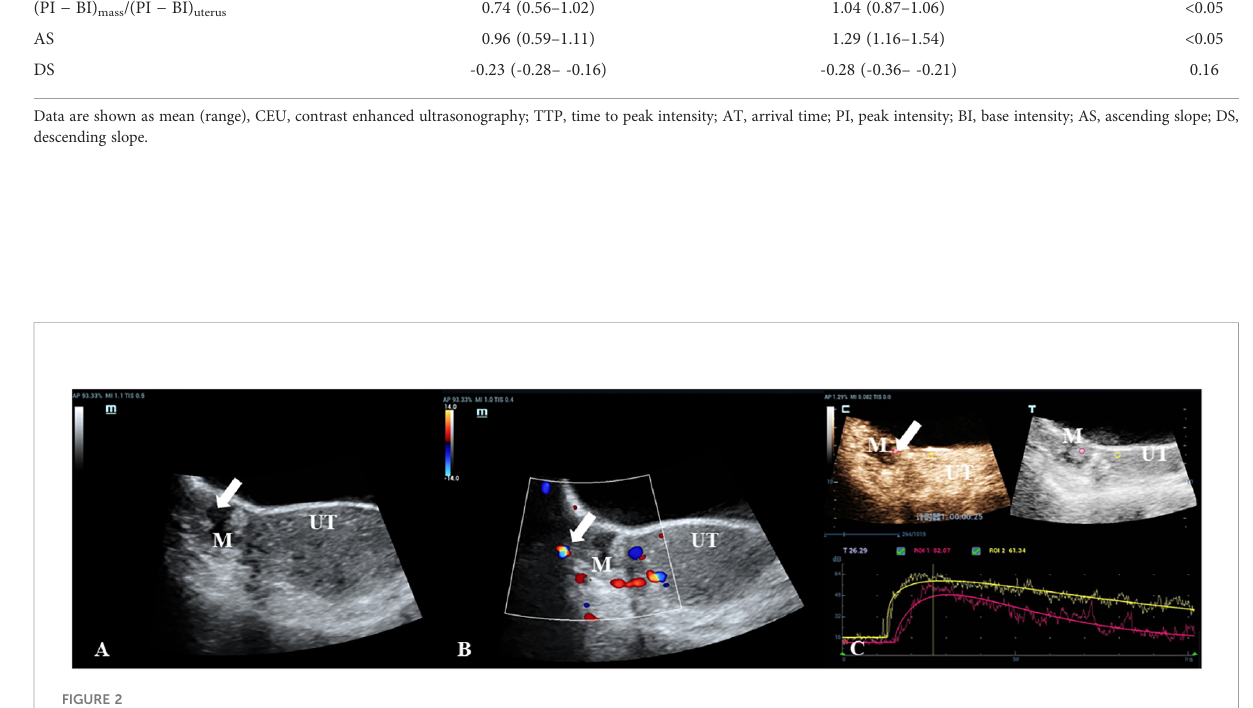
FIGURE 2 A 30-year-old woman with a pathologically proven borderline cystadenoma. (A) Transabdominal gray-scale ultrasound shows an 18-mm cystic mass (M) with a small 13 x 8mm papillary component at the right of uterus (UT). (B) Color Doppler reveals no blood fl ow signal in the papillary